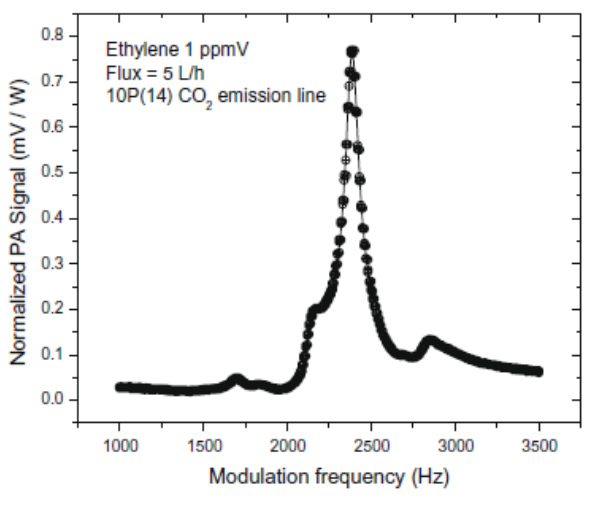
Figure 2. Resonance curve showing the photoacoustic signal variation with the chopper modulation